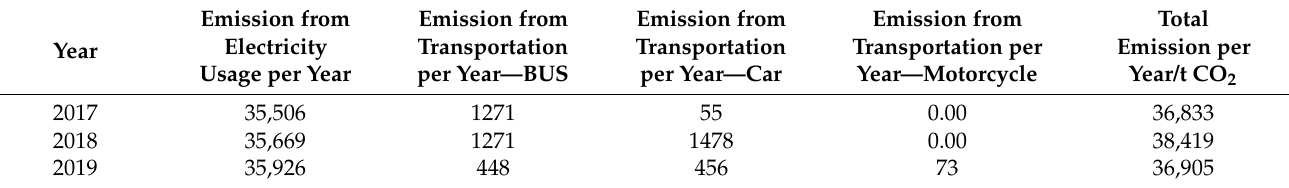
Table 1. University of Bologna carbon footprint calculated using Green Metric